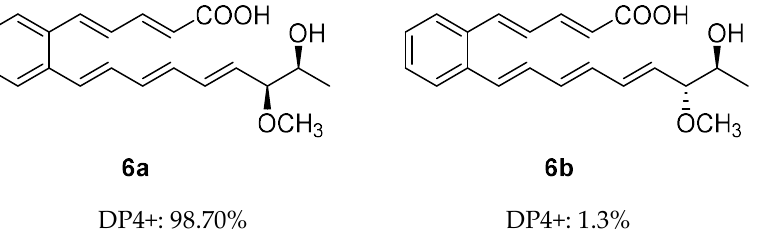
Figure 4. DP4+ probability of two plausible epimers 6a and 6b of 6 ( 6a : rel-(18 R ,19 R ). 6b: rel- (18 S ,19 R )).